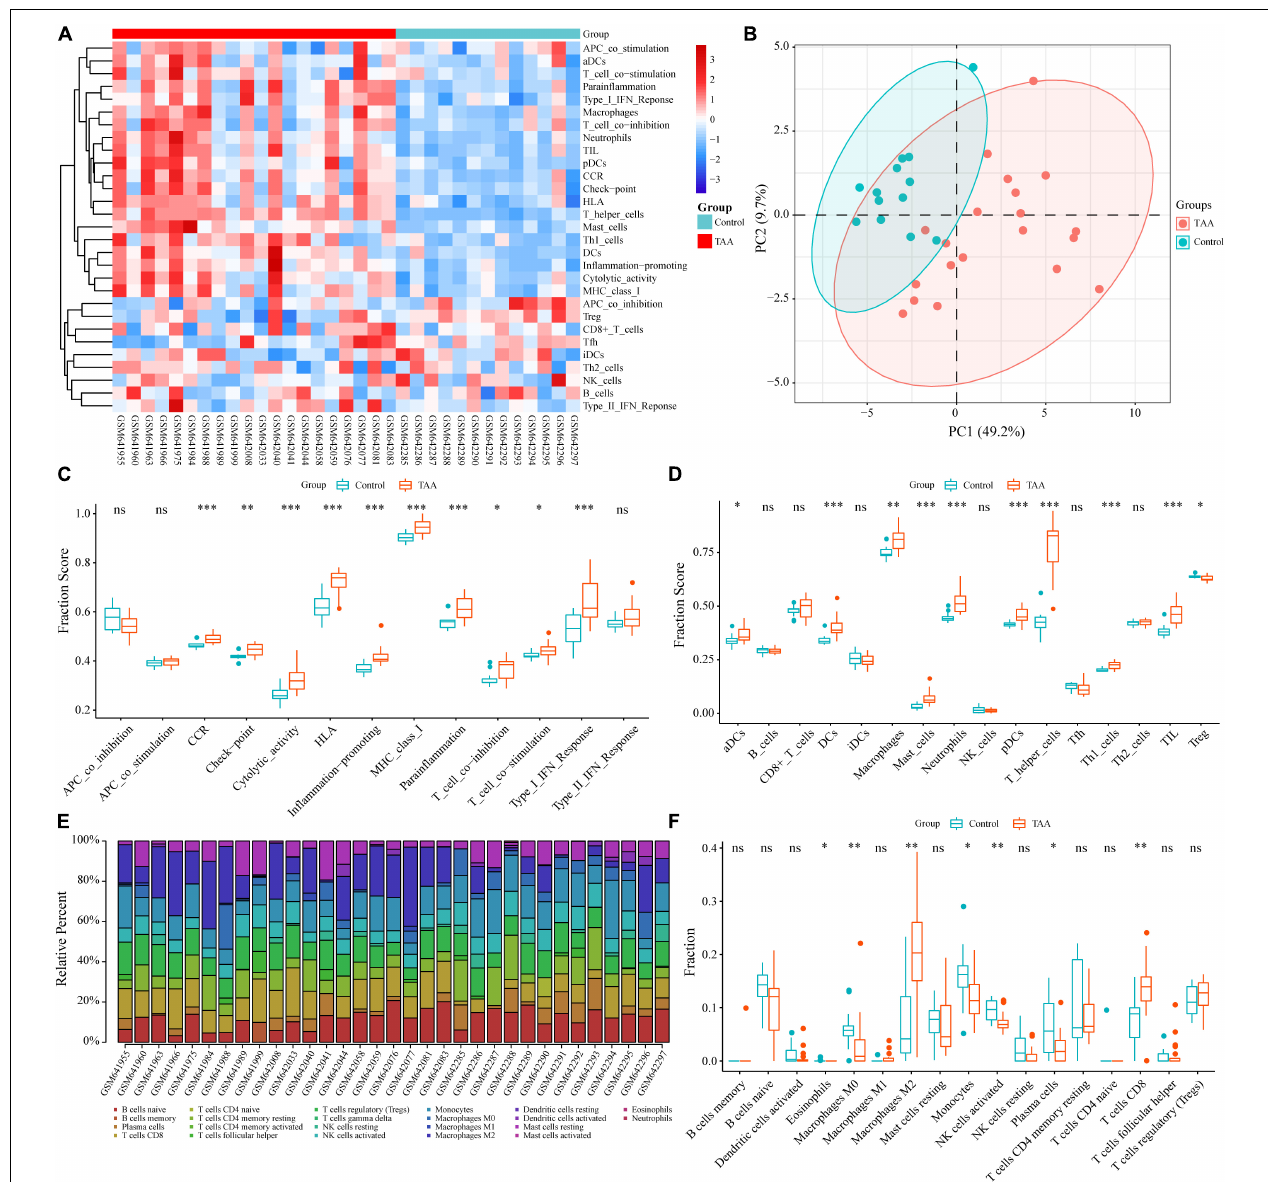
FIGURE 2 | Identification of the infiltrating immune cells and immune functions in TAA. (A) Twenty-nine immune-related gene sets, including 16 immune cells and 13 immune processes, were enriched by ssGSEA. (B) Two distinct group-bias clusters were identified by PCA based on the 29 immune-related gene sets. (C,D) The fractions of immune processes (C) and immune cells (D) between TAA and control samples are shown in boxplots. (E) The fractions of 22 types of immunocytes in each sample were identified by the CIBERSORT algorithm and are shown in the histogram. (F) The differences in immune infiltration levels between TAA and control samples, based on the CIBERSORT algorithm, are shown in a boxplot. ns: no significance; ∗ P < 0.05; ∗∗ P < 0.01; ∗∗∗ P <